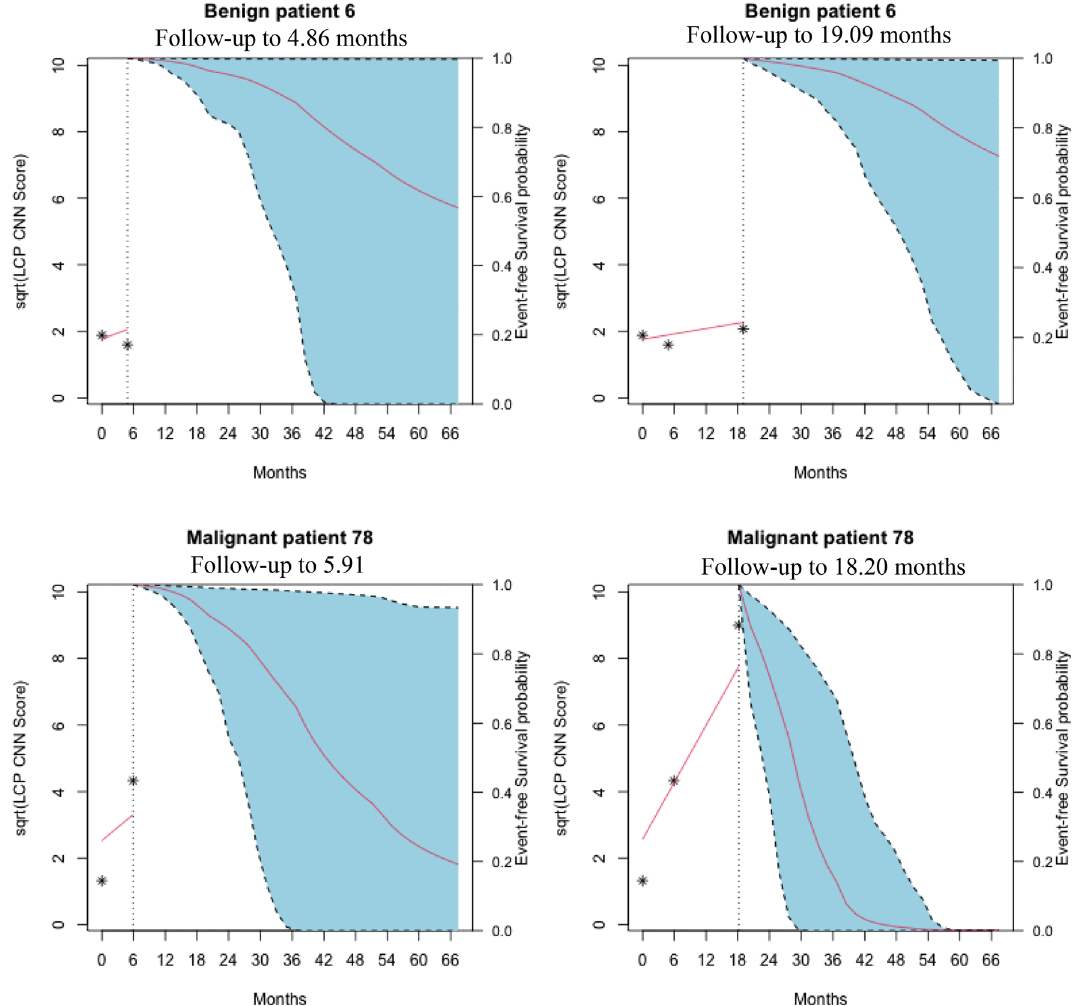
Figure 3. Dynamic predicted probabilities of event-free (non-malignant) survival for a benign patient 6 (top panel) and a malignant patient 78 (bottom panel) estimated with the joint model. The LCP CNN longitudinal score (star points) for the second visit (left panel) and the third visit (right panel) are shown. The vertical dotted lines represent the time point of the last probability. Left of the vertical line, the fitted longitudinal trajectory (solid line) is depicted. Right of the vertical line, prediction of the conditional probabilities of event-free survival (solid line) with 95% confidence intervals (dashed